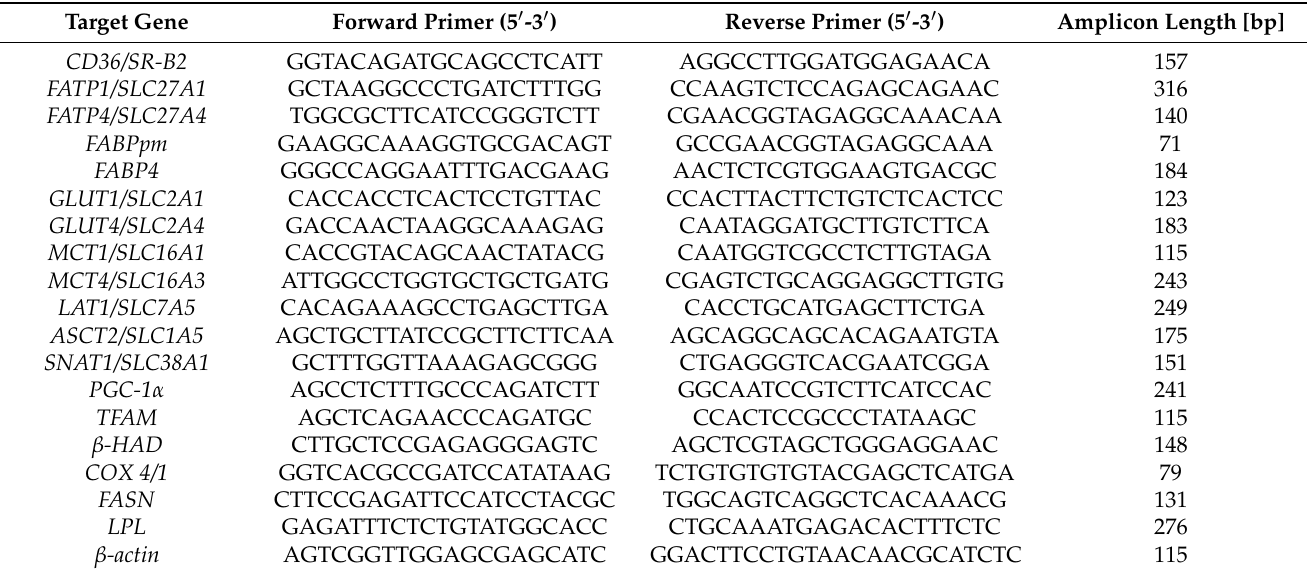
Table 4. Primer sequences used for real-time